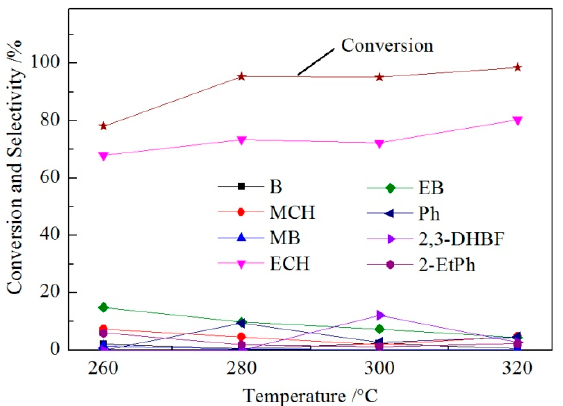
Figure 8. Conversion and product distribution of Ni 5 Cu 5 / γ -Al 2 O 3 catalyst with the reaction